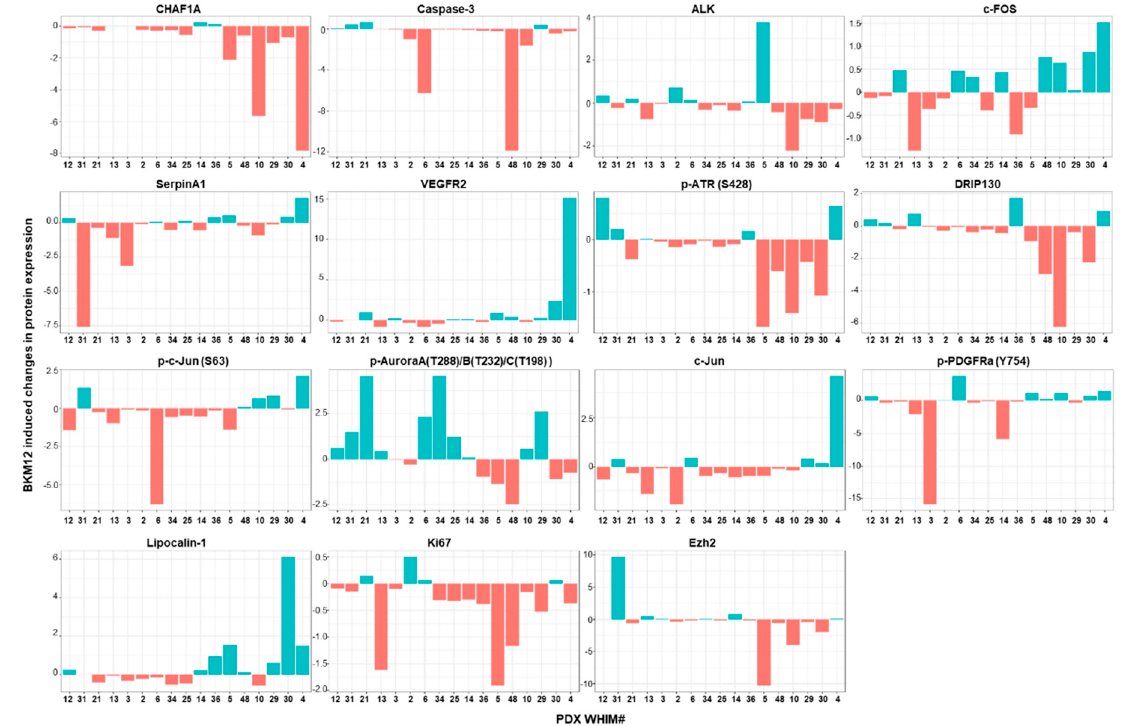
Figure 5. Barplot of RPPA proteins with expression change significantly correlated TGI. BKM120 induced changes are derived using the formula (mean protein level post BKM120 minus mean protein level post vehicle) / mean protein level post vehicle treatment. Bar graphs are ordered based on %TGI from less to more sensitive to BKM120.